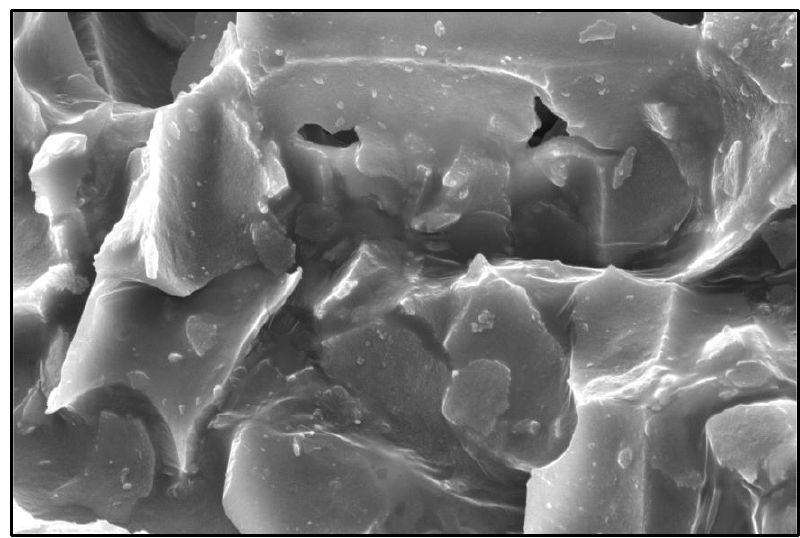
Figure 6. SEM image of optimized NS IBNS4.